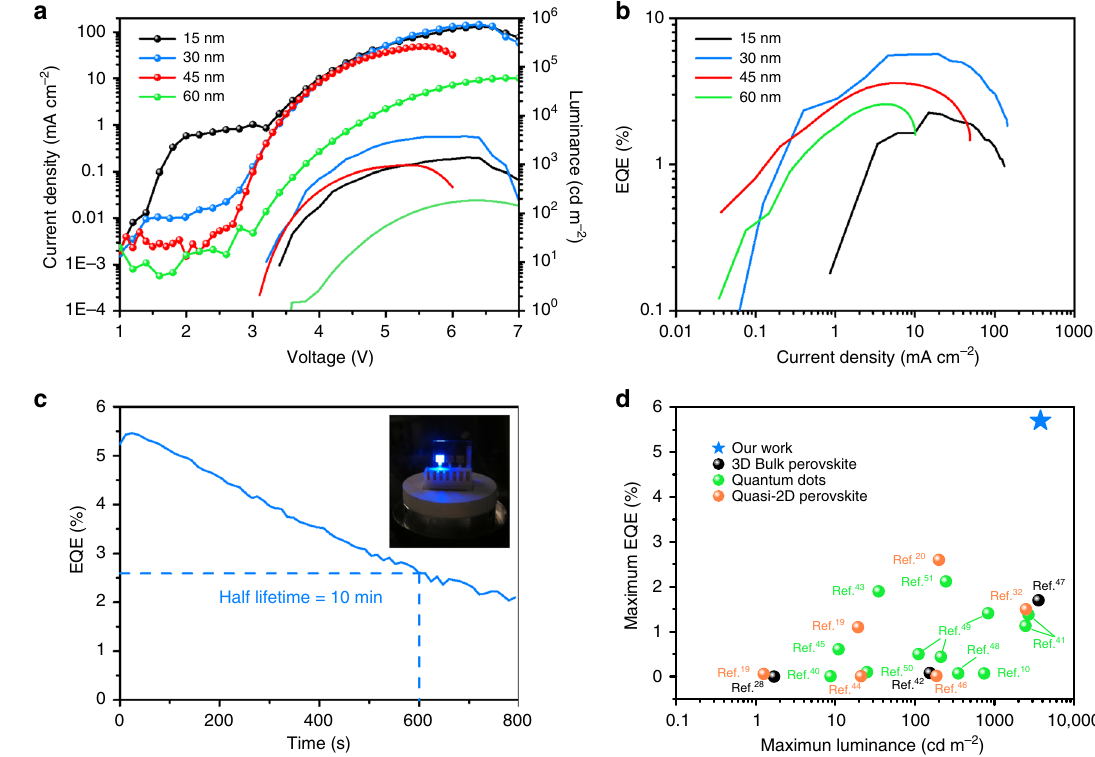
Fig. 5 Performance of perovskite light-emitting diode (LEDs) (100% phenylethylammonium bromide (PEABr) case) with different PEDOT:PSS thicknesses. a Characterization of current density and luminance versus voltage. The solid lines and lines with dots correspond to luminance and current density, respectively. b Characterization of external quantum ef fi ciency (EQE) versus current density. c Operating lifetime of a perovskite LED under a constant applied voltage of 4.4V and a photo of a working perovskite LED. d Comparison of our work with the currently published results based on blue-emissive perovskite LEDs with emission in the range of 450 – 500